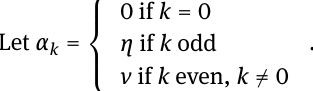
(iii) Let us consider the probability P (cid:0) B 1